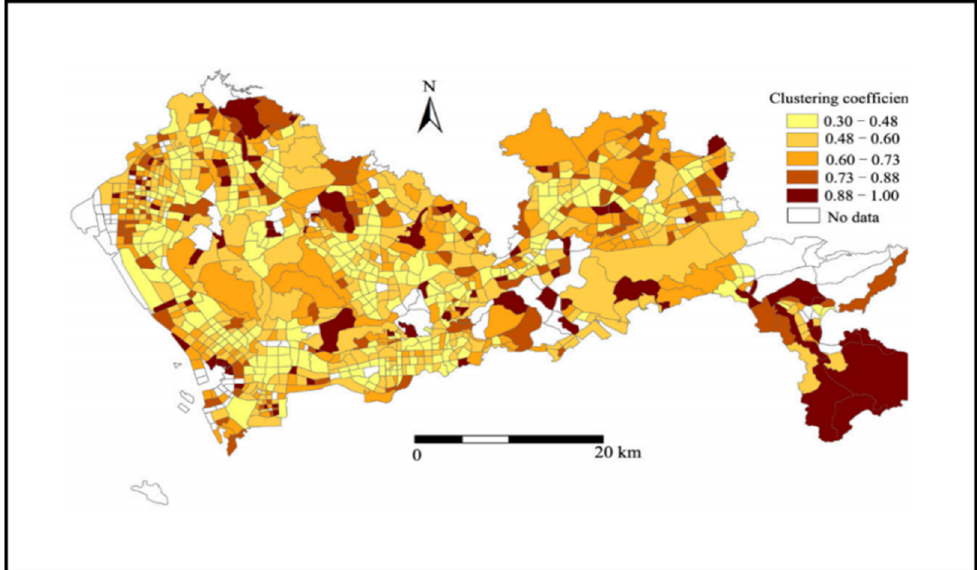
Figure 3. Spatial distribution of the clustering coefficient